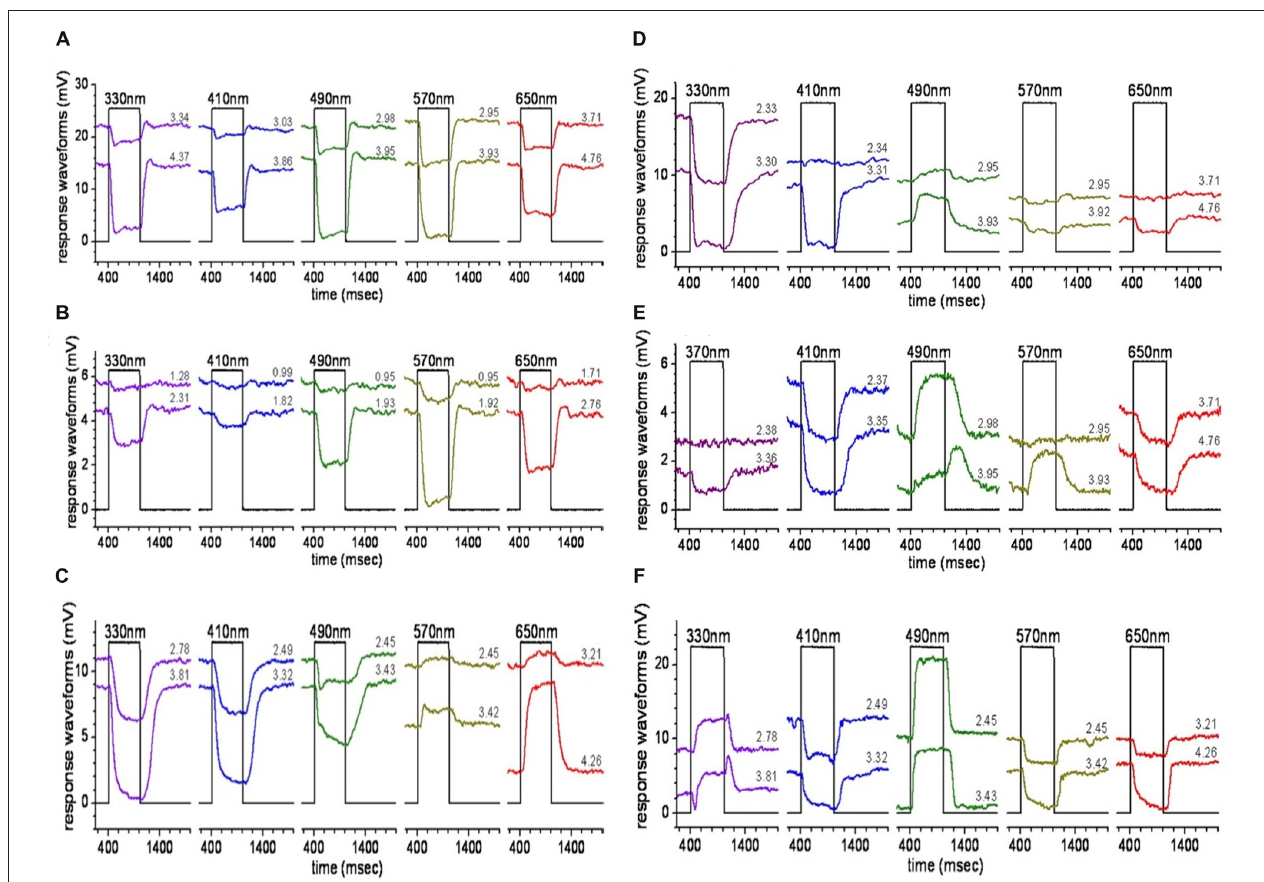
FIGURE 3 | HC responses. Stimulation of zebrafish eyecups with light of different spectral wavelengths evokes different responses from zebrafish HCs. (A,B) H1-type cells hyperpolarize to all wavelengths, giving an L-type response; while (C) H2 cells are biphasic, hyperpolarizing to G, B, and ultraviolet (UV) and depolarizing to R light. H3-type HCs, in contrast, display triphasic (D,E) and tetraphasic (F) responses to spectral stimuli (from Connaughton and Nelson, 2010).